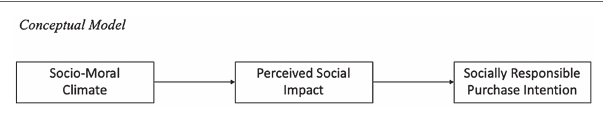
FIGURE 1 | Conceptual